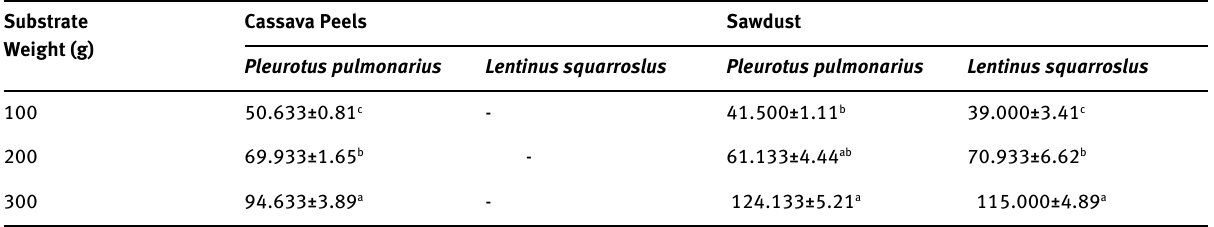
Table 2: Fruiting pattern of Cassava Peels Spawn of Pleurotus pulmonarius and Lentinus squarroslus on Cassava peels and Sawdust Substrate